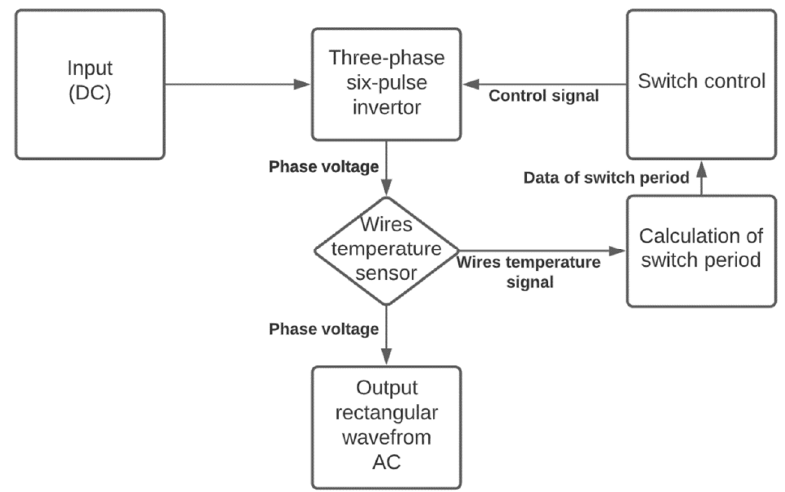
Figure 7. Block diagram of the switching system.